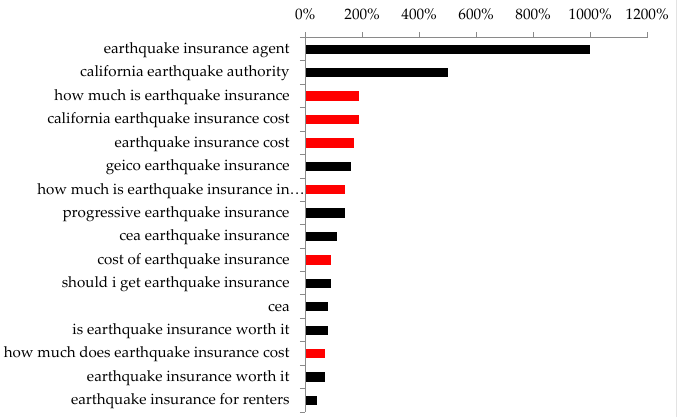
Figure 8. GT-related queries (rising option) for 2016–2021 (III period). In red, the queries having the same meaning (cost of coverage).